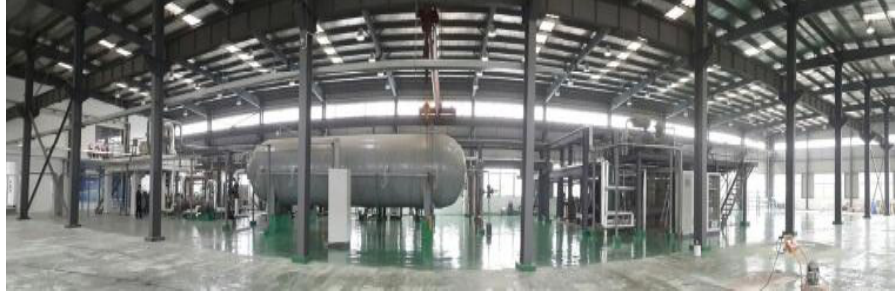
Figure 12. TICC-500 pilot plant [58].